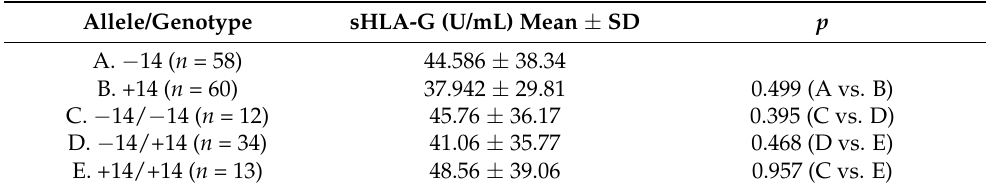
Table 5. Association between HLA-G 14bp ins/del polymorphism and the level of sHLA-G in glioma patients ( n = 59).